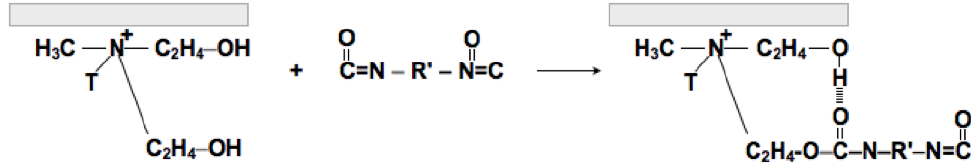
Figure 6. Representation of the interactions between quaternary ammonium-treated clay and polyurethane.